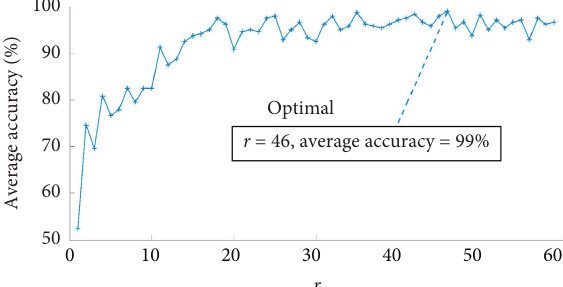
Figure 10: Average recognition accuracy of loudspeaker validation set under different r